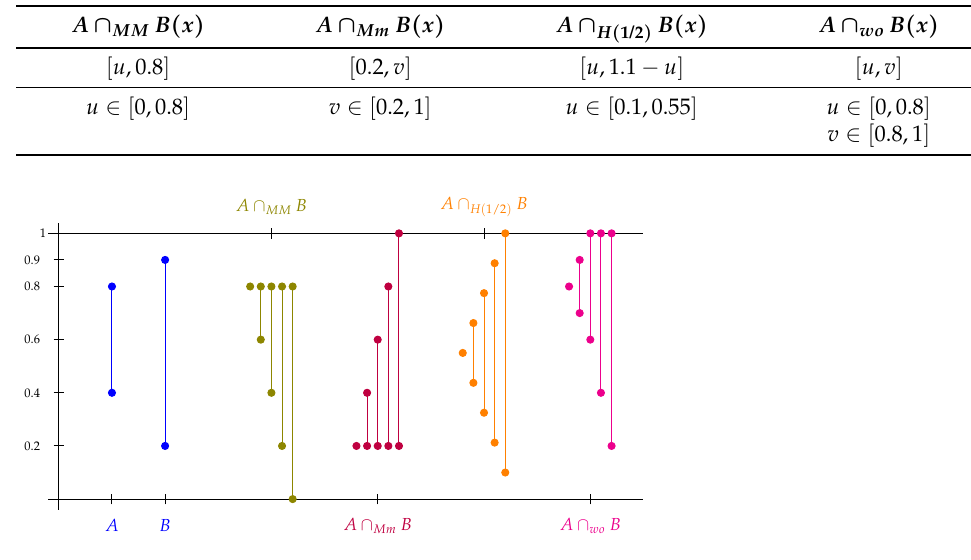
Figure 6. Intersection for different orders.